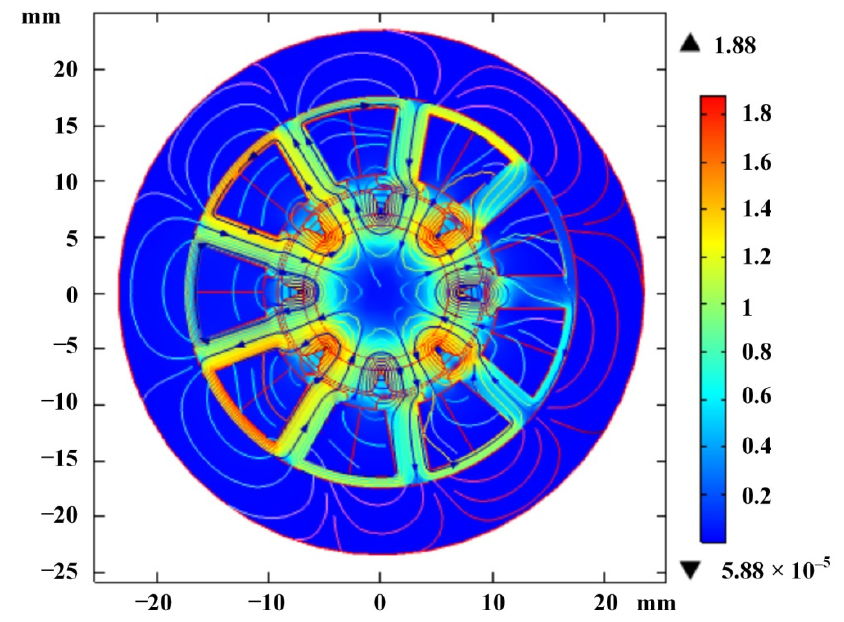
Figure 19. Distribution of magnetic flux density.